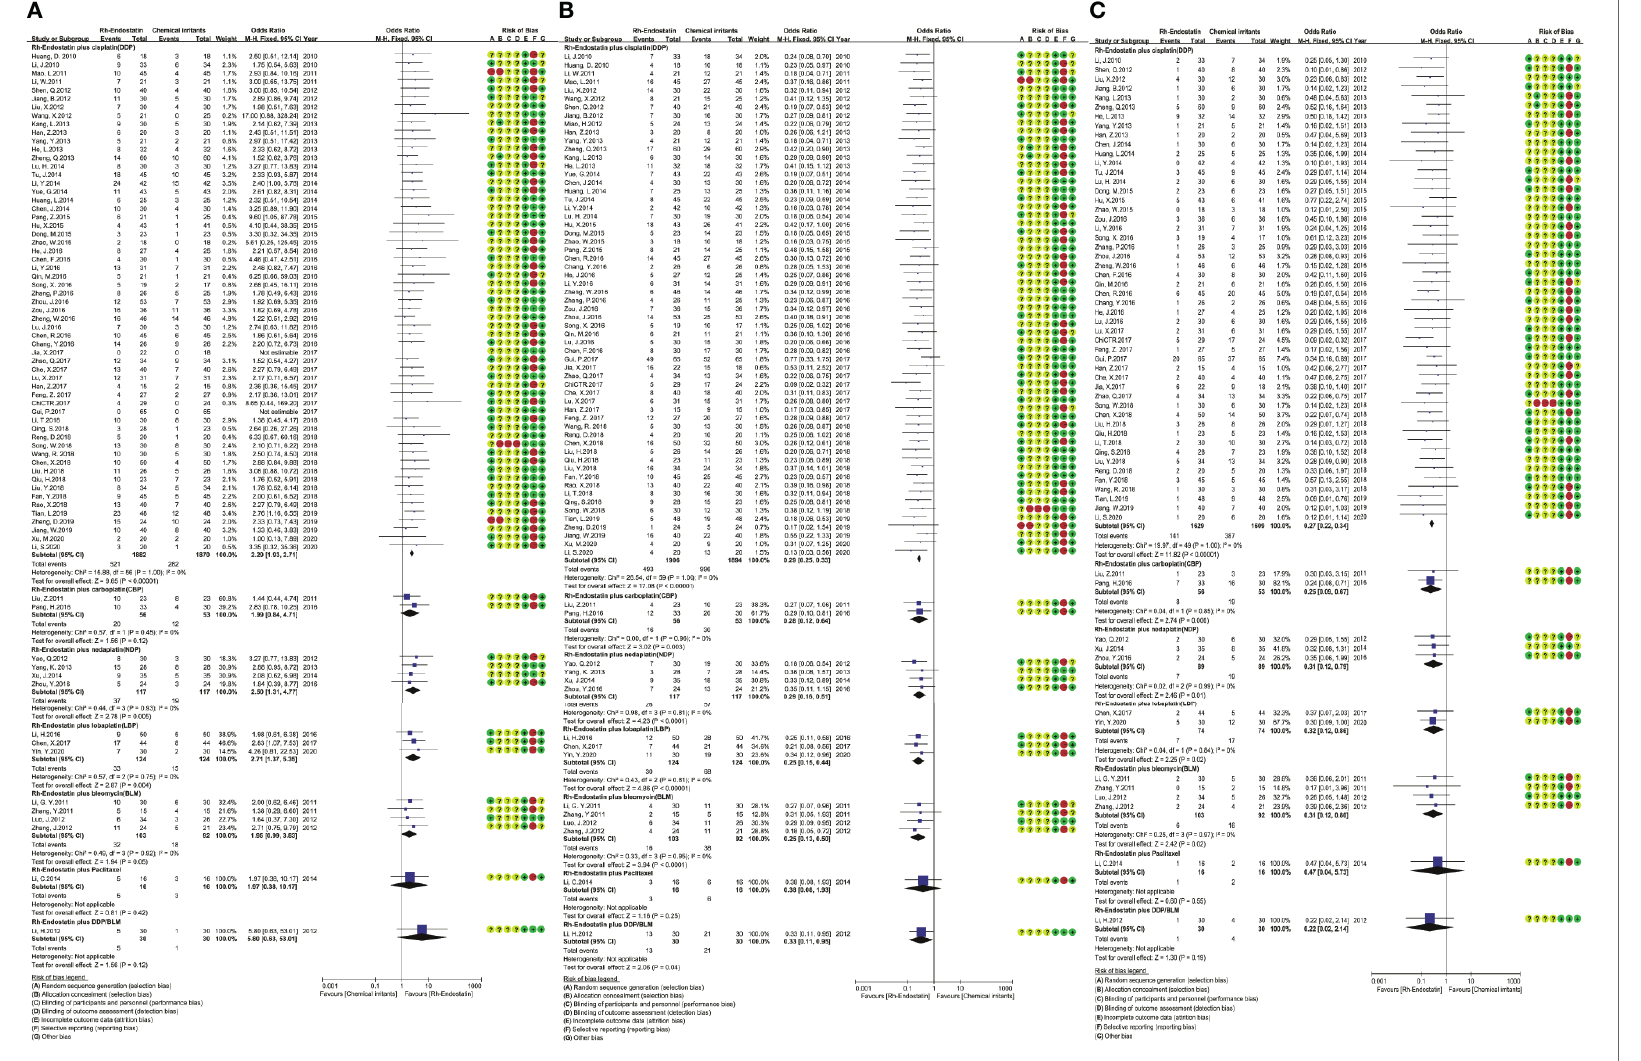
FIGURE 3 | The analysis of clinical responses between the two groups. (A) The forest plot of complete response. (B) The forest plot of treatment failure. (C) The forest plot of progressive